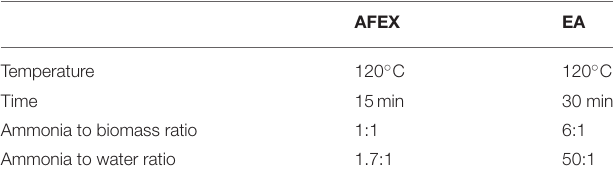
TABLE 1 | Pretreatment conditions of AFEX and EA process.